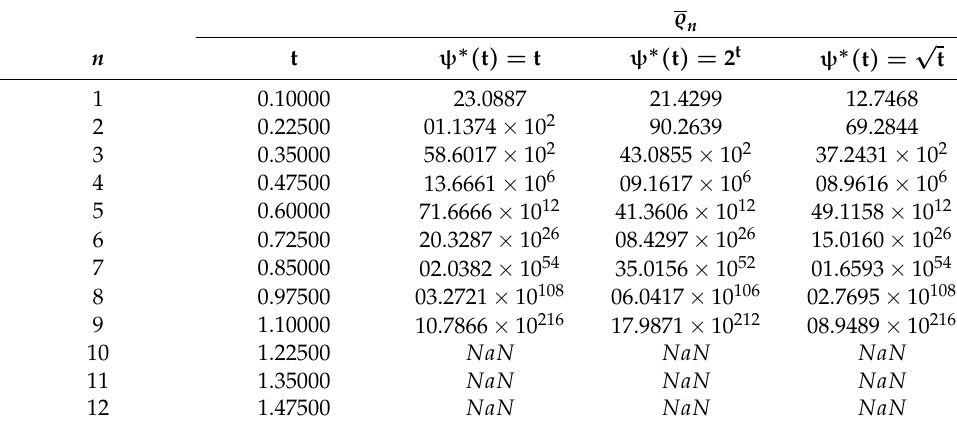
for ψ ∗ ( t ) = t,2 t , n